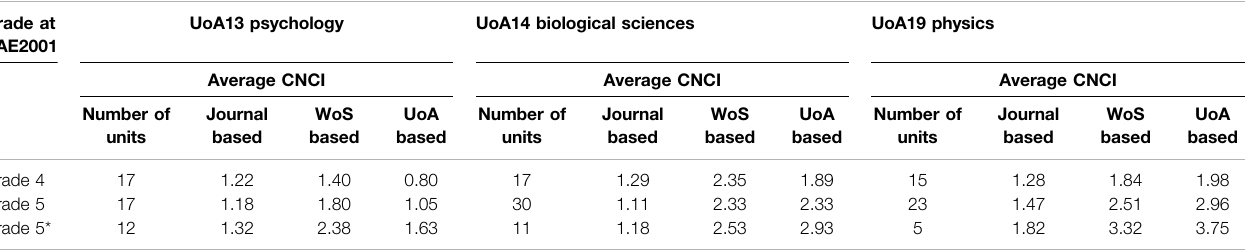
TABLE2| TheaverageCategoryNormalizedCitationImpact(CNCI)ofarticlesandreviewspublishedduring1996 – 2000byresearchstaffatUnitedKingdomuniversitiesfor units graded 4, 5 or 5* in the Research Assessment Exercise 2001 (RAE2001). Data are shown for three Units of Assessment (UoA) with the numbers of units at each grade and the CNCI for their publications with citation counts normalized at three levels of granularity: the journal of publication; the Web of Science (WoS) journal category; and the data set for the entire UoA (Adams et al., 2008).